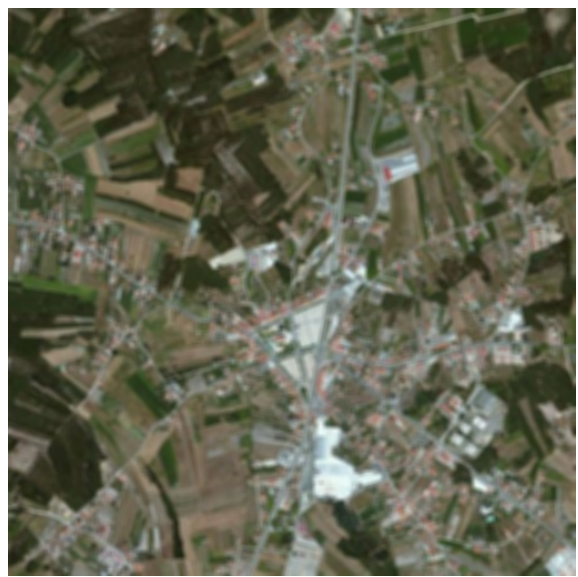
Figure 2. Color multispectral image. Blurred version of Figure 3.